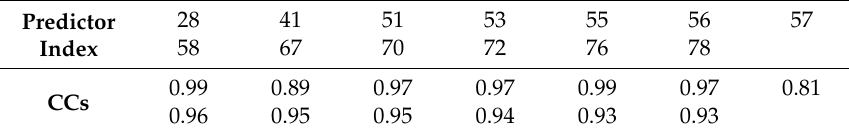
Table 2. The maximum of correlation coe ffi cients (CCs) between eliminated predictors and remaining predictors. The names of predictors corresponding to the indices are listed in the Appendix